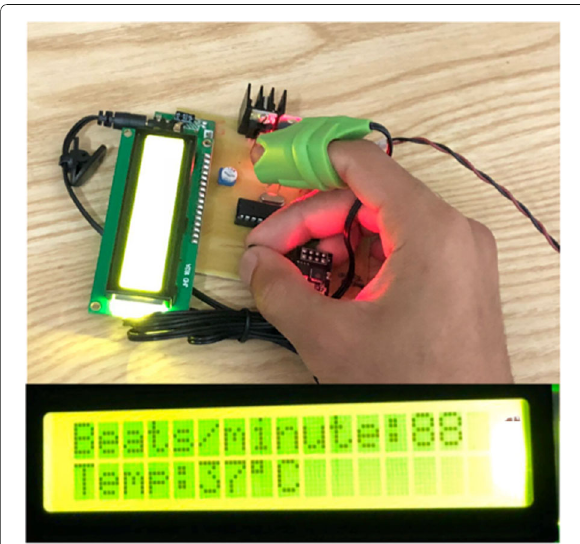
Fig.4 The LCD embedded within the BAN component in WISE